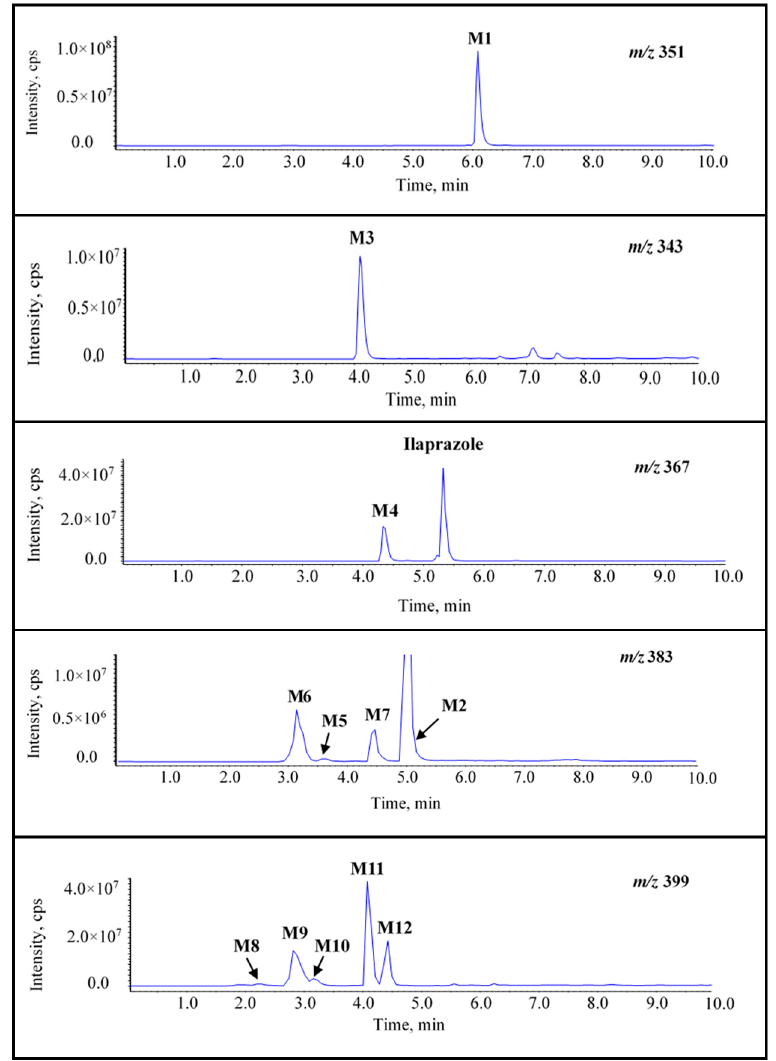
Figure 2. The enhanced product ion (EPI) chromatograms of ilaprazole and twelve metabolites.